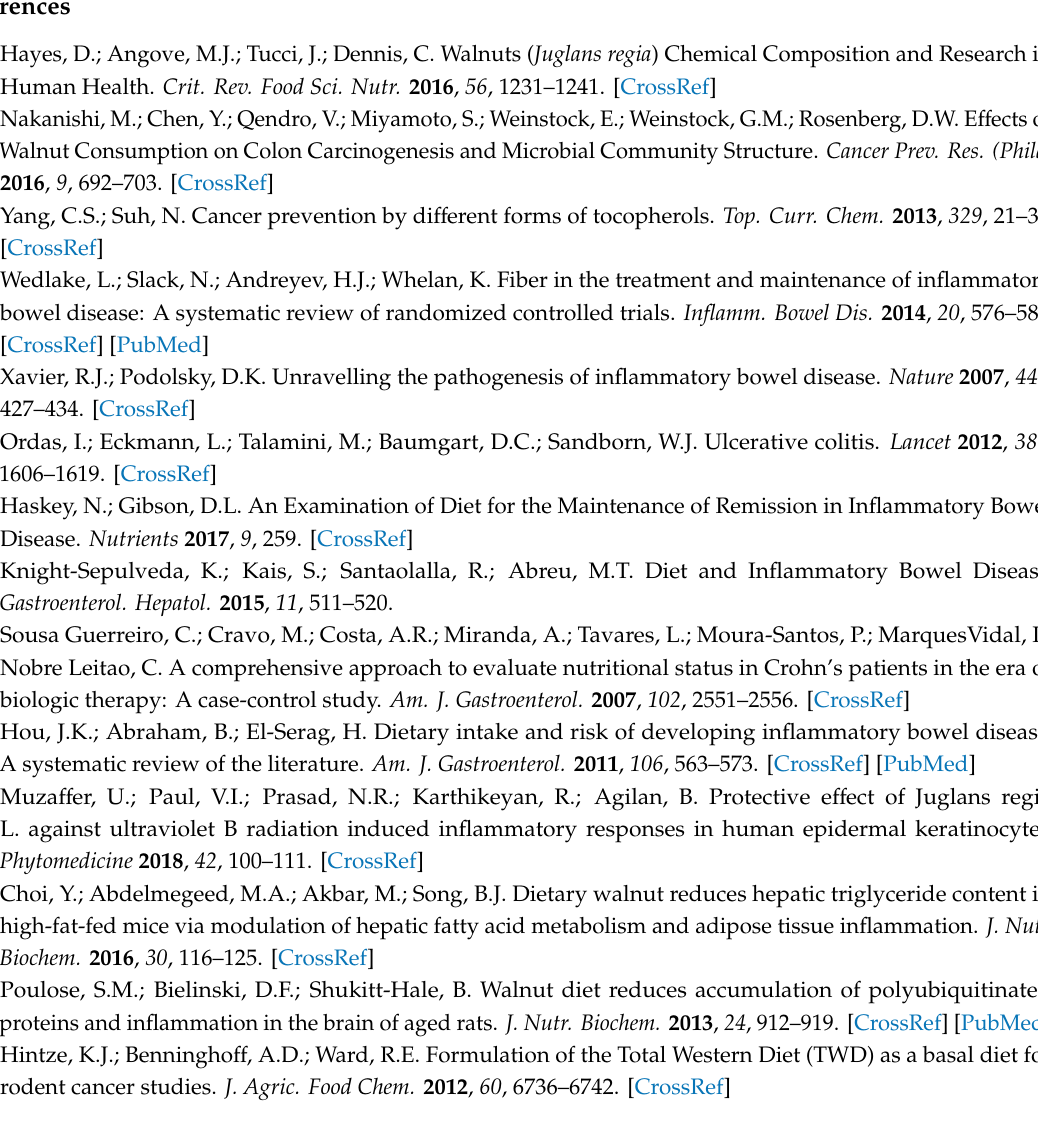
Table S1: Macronutrient and fatty acid composition of the TWD diet, Figure S1: Linear-regression analyses of ulceration and